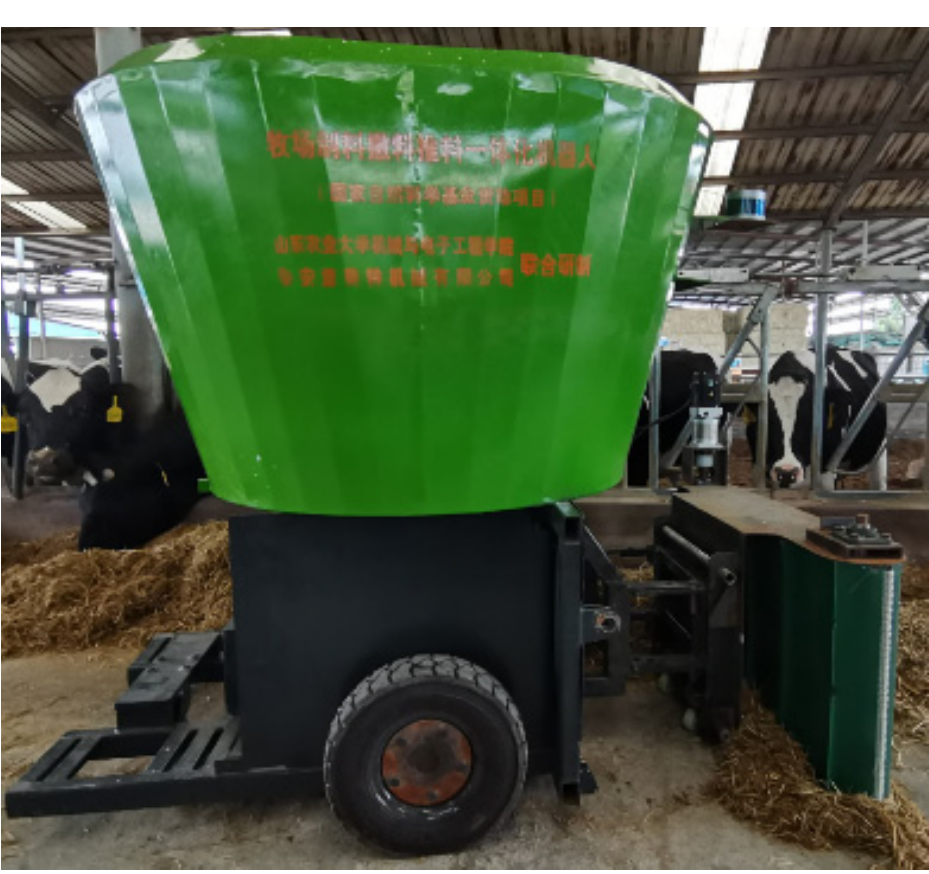
Figure 2. The Pusher Robot.